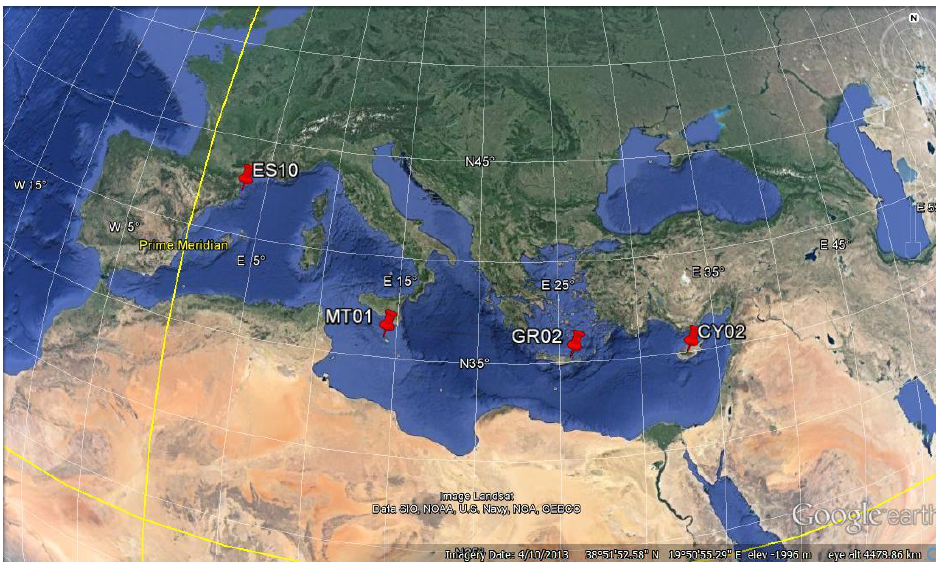
Figure 1. Map of the Mediterranean basin with the locations of the 4 EMEP stations 869 Fig. 1. Map of the Mediterranean Basin with the locations of the four EMEP stations marked: Cabo de Creus, Spain (ES10); Gozo, Malta (MT01); Finokalia, Greece (GR02); and Ag. Marina, Cyprus (CY02). Keep in mind that the positions of the cross sections of Figs. 5 and 7 marked: Cabo de Creus, Spain (ES10), Gozo, Malta (MT01), Finokalia, Greece 870 are indicated in the map by the 35 ◦ N meridian and the 25 ◦ E parallel crossing the island of Crete, (GR02) and Ag. Marina, Cyprus (CY02). Mind that the positions of the cross sections 871 of Figures 5 and 7 are indicated in the map by the N35 o meridian and the E25 o parallel 872 crossing the island of Crete, Greece. 873